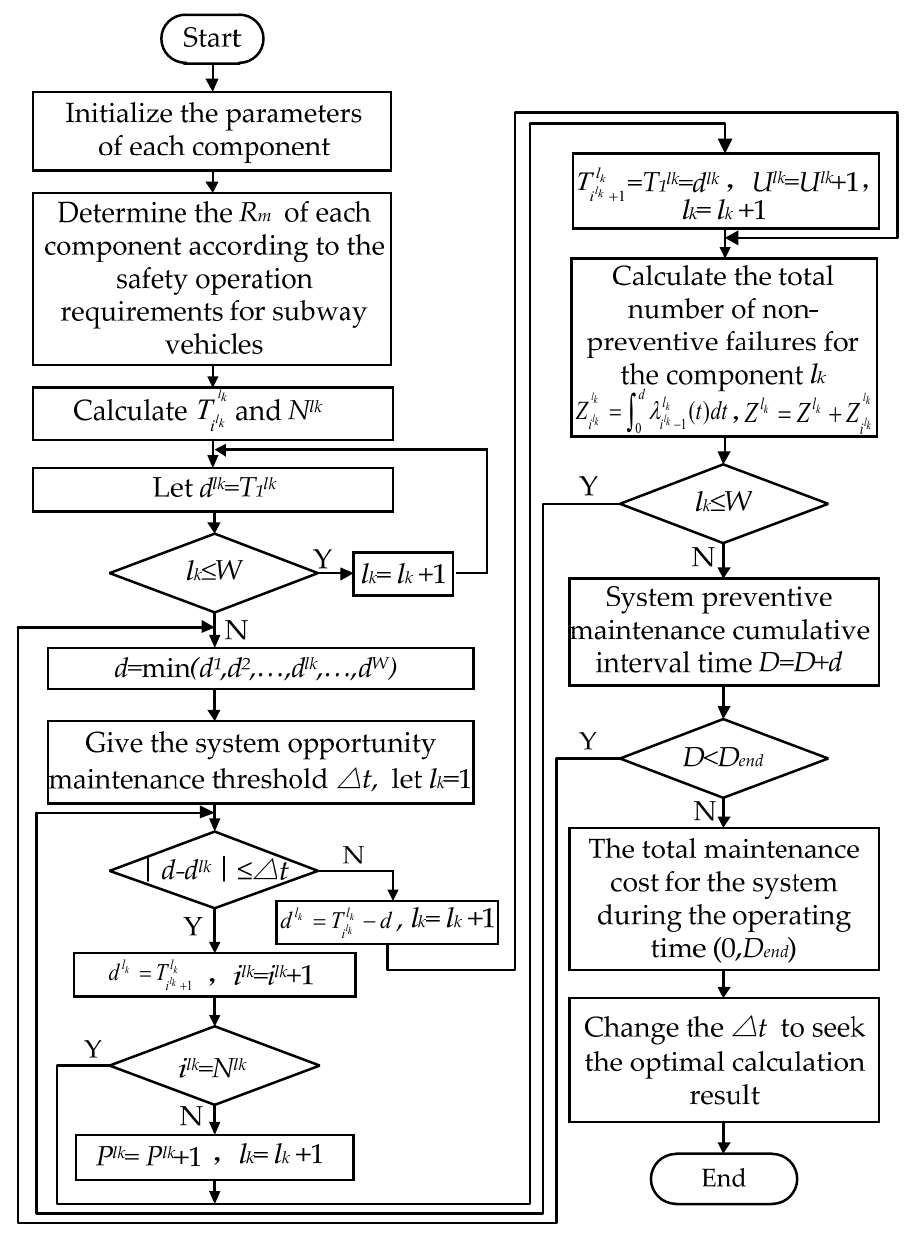
Figure 6. Model solving process.